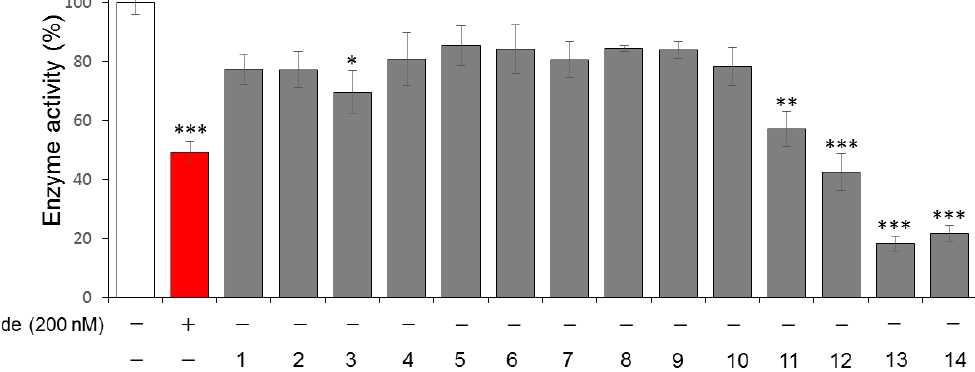
Figure 4. Inhibitory effect of 14 isolated compounds from H. Japonicus on MAO B based on fluorescent characteristics of 4-hydroxyquinoline, which is the product of the redox reaction catalyzed by MAO B. The inhibitory activity against MAO B was determined after MAO B was incubated with 14 compounds isolated from H. Japonicus at 20 µM . Values represent the relative activity of MAO B compared to the control group without addition of these inhibitory compounds as the mean ± SD (n = 3), * p < 0.05, ** p < 0.01 and *** p < 0.001.